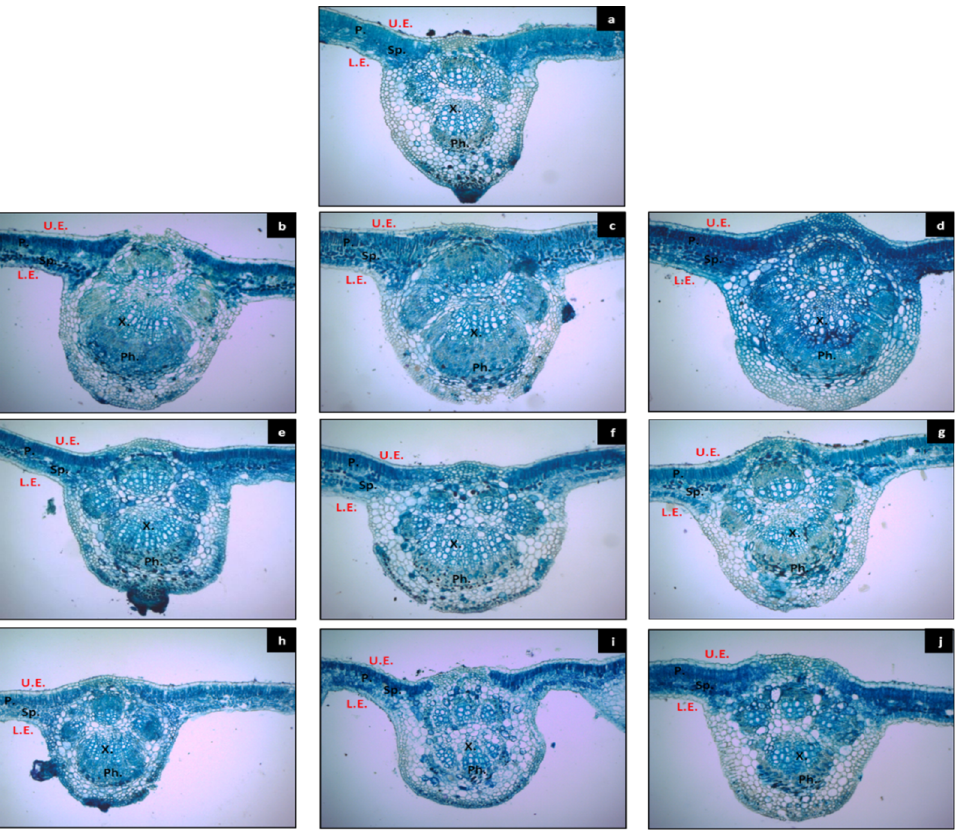
Figure 4. Microphotographs of cross-sections through the blade of leaves on the median portion of grapevine aged 135 days as affected by salinity (NaCl) and brassioloide (BL) (LE, Lower epidermis; P, Palisade parenchyma; SP, Spongy parenchyma; UE, Upper epidermis; X, xylem; Ph, phloem; ( a ), 0 NaCl without BL application; ( b ), 1000 mg L − 1 NaCl without BL application; ( c ), 1000 mg L − 1 NaCl with 1 mg L − 1 BL application; ( d ), 1000 mg L − 1 NaCl with2 mg L − 1 BL application; ( e ), 2000 mg L − 1 NaCl without BL application; ( f ), 2000 mg L − 1 NaCl with 1 mg L − 1 BL application; ( g ), 2000 mg L − 1 NaCl with 2 mg L − 1 BL application; ( h ), 3000 mg L − 1 NaCl without BL application; ( i ), 3000 mg L −